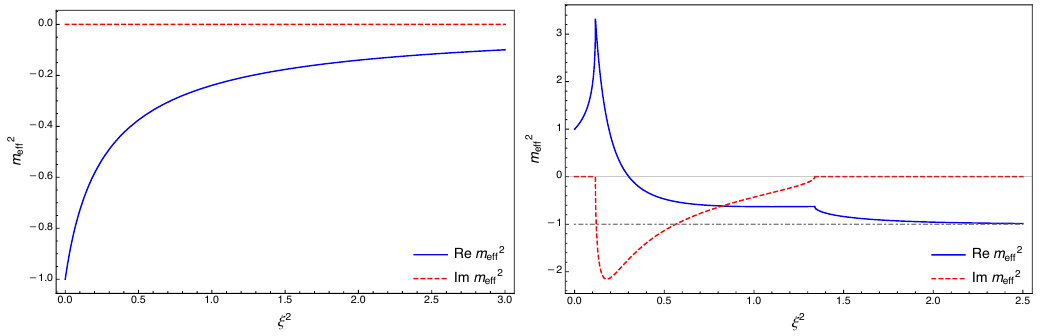
Figure 6 . Effective mass-squared as a function of ξ 2 on the principal branch of the Lambert function. Left: massive theory. Since this represents the unstable vacuum, the mass-squared goes to − 1 as ξ → 0 . The mass-squared is real. Right: tachyonic theory. Since this represents the stable vacuum, the mass-squared goes to +1 as ξ → 0 . Here, the mass-squared acquires a non-zero imaginary part for a range of values of ξ